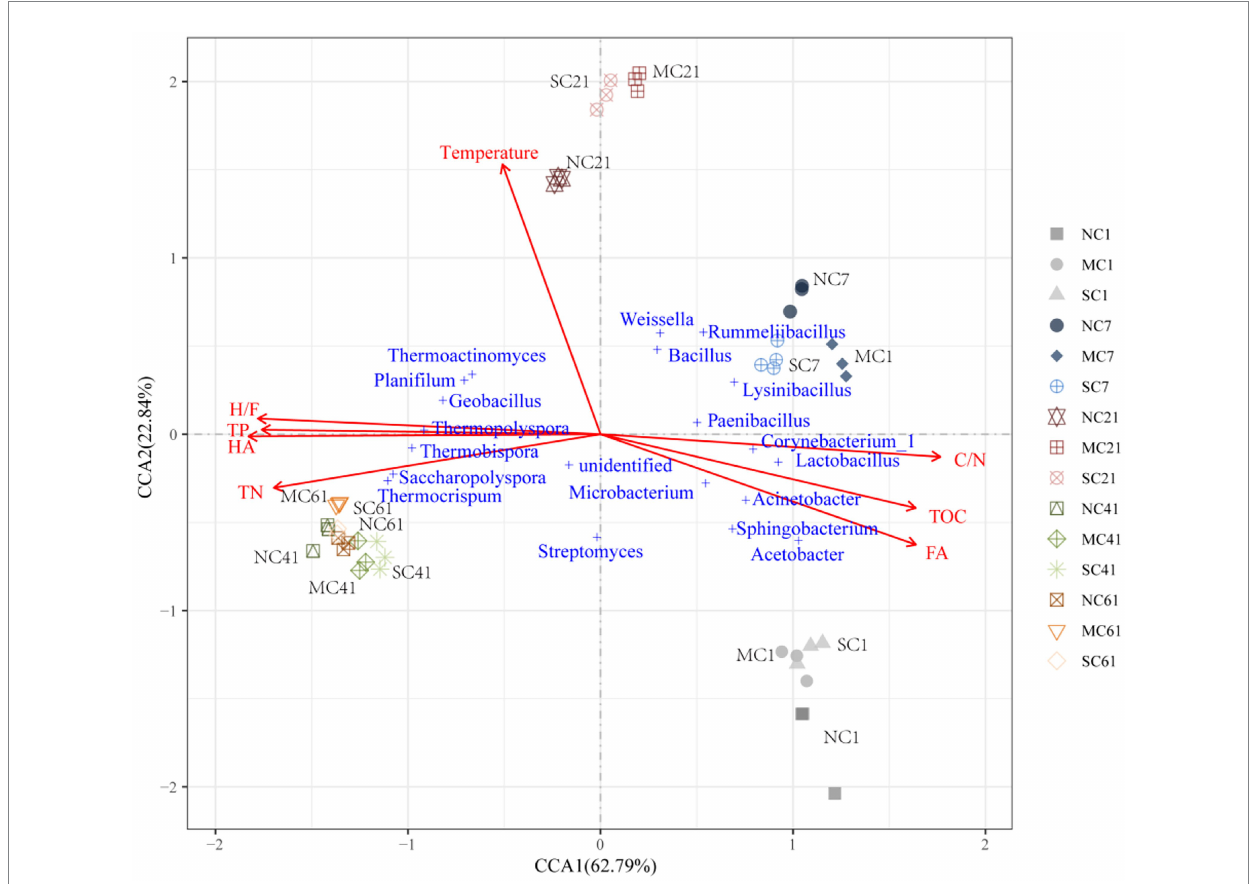
FIGURE 5 Canonical correspondence analysis of the bacterial community and environmental factors during composting. TOC, TN, HA, and FA denote the total organic carbon, total nitrogen, humic acid, and fulvic acid, respectively. C/N and H/F denote the TOC-to-TN ratio and HA-to-FA ratio,